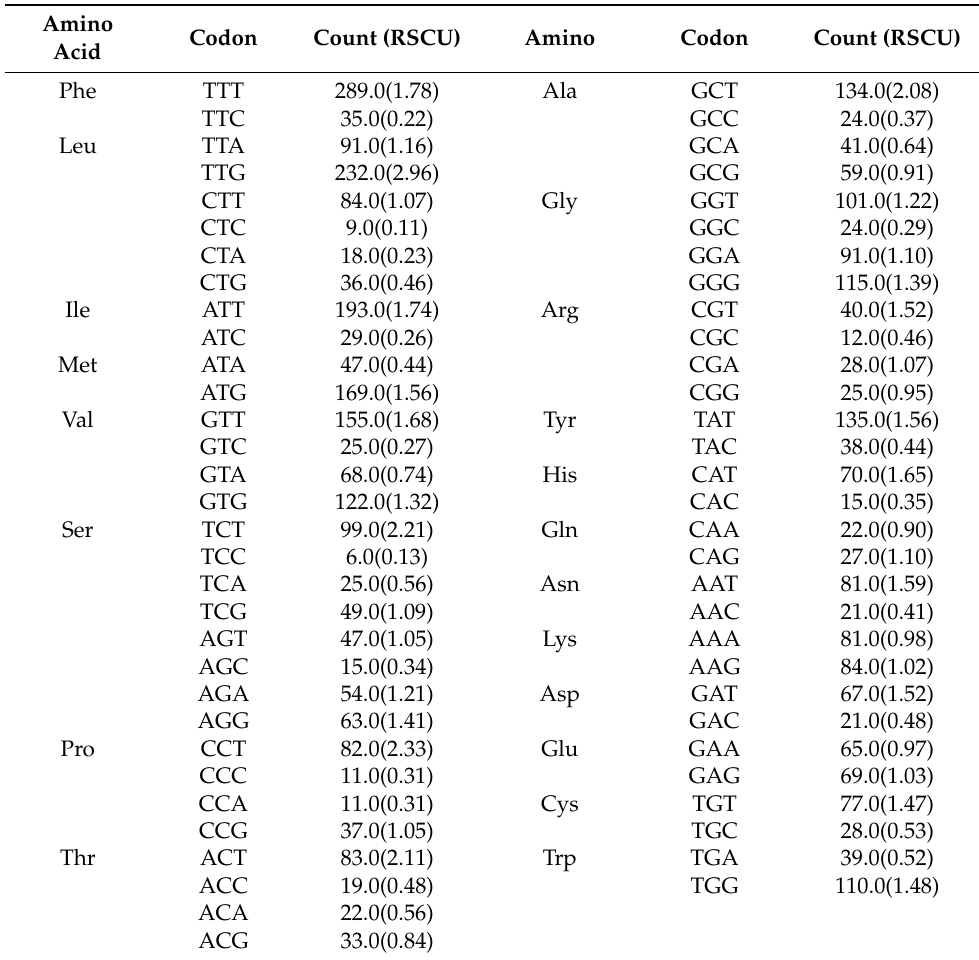
Table 4. Codon and relative synonymous codon usage (RSCU) of 12 protein-coding genes (PCGs) in the mtDNA of Hyotissa hyotis